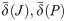
Observability coefficients of fisheries model.Observability coefficient of system variables δ¯(J),δ¯(P), and δ¯(A) as a function of μP calculated using the definition in Eq (24). Lie derivatives are used to construct the observability matrix from which the observability coefficients are calculated. See text for details. A geometrically spaced vector of predator mortality rate is used to cover the range 0.4 ≤ μP ≤ μB2.